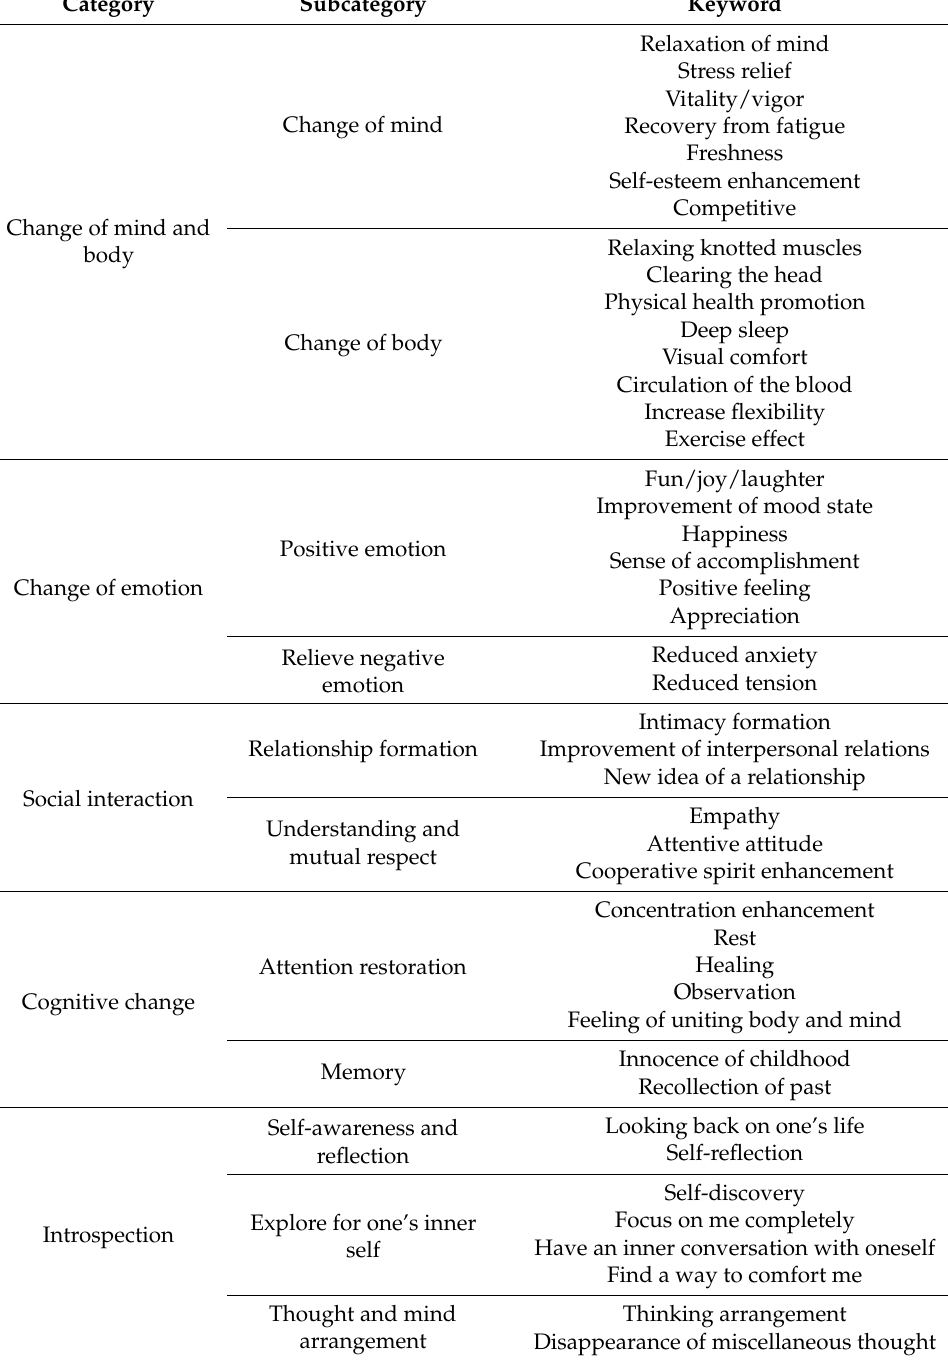
Table 3. Written response category and keywords on health benefits by type of forest therapy